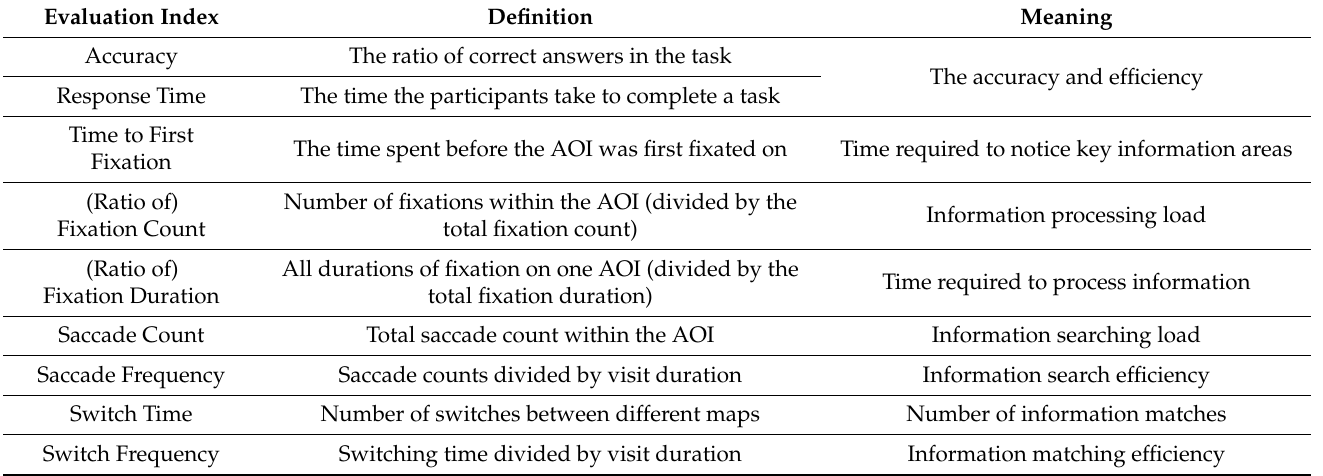
Table 1. Definitions and Meaning of the Metrics.